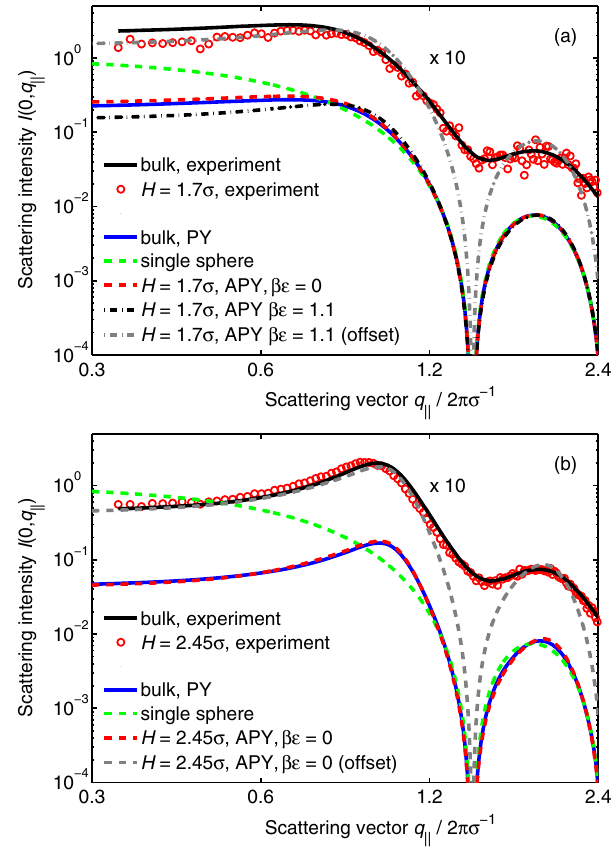
FIG. 9. Mutually normalized x-ray scattering intensities ob- ¼ 0 . 38 σ − 3 ) and tained from (a) the moderately dense ( n b ¼ 0 . 75 σ − 3 ) hard-sphere fluid. In both cases we (b) dense ( n b present experimental data obtained from both bulk (solid black line) and confinement (red circles), as well as corresponding theoretical data for bulk (blue solid line), hard confinement (dashed red line), and a single sphere (i.e., the form factor; green dashed line). For the moderately dense fluid we also present theoretical data for slightly sticky hard confinement (dashed- dotted black line). See text for details on the theoretical calculations. The experimental data are offset vertically by a factor of ten for clarity, and we present one of the theoretical curves (gray curve) also vertically offset to facilitate comparison. The deviation between the theoretical and experimental data around the deep minima should be disregarded in the comparison, see